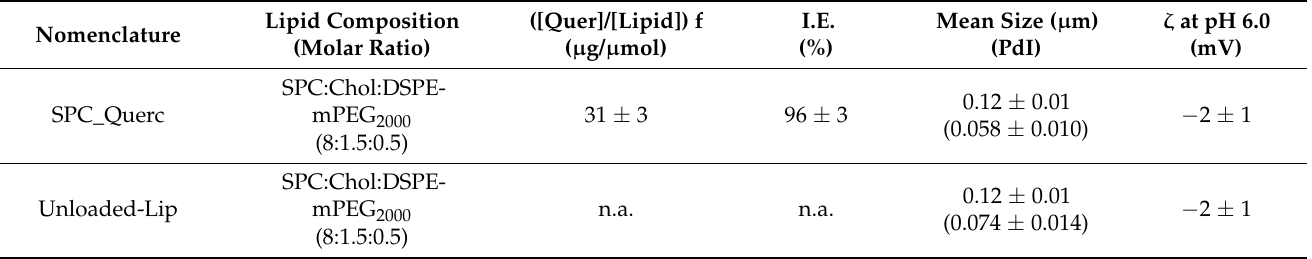
Table 3. Full characterization of quercetin nanoformulation (SPC_Querc) and empty liposomes (Unloaded-Lip) according to the lipid composition, the loading capacity (final drug-to-lipid ratio), incorporation efficiency (I.E.), mean size, polydispersity index (PDI), and zeta potential ( ζ ) at pH 6.0 ( n =